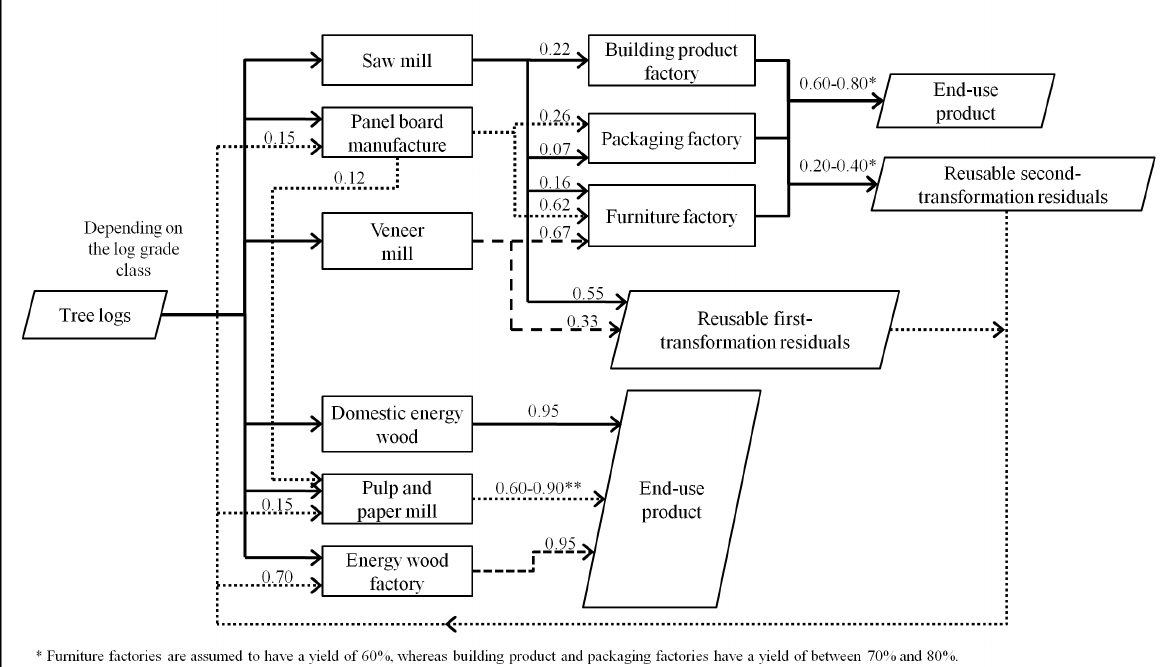
Figure 2. Production lines module in the carbon assessment tool.